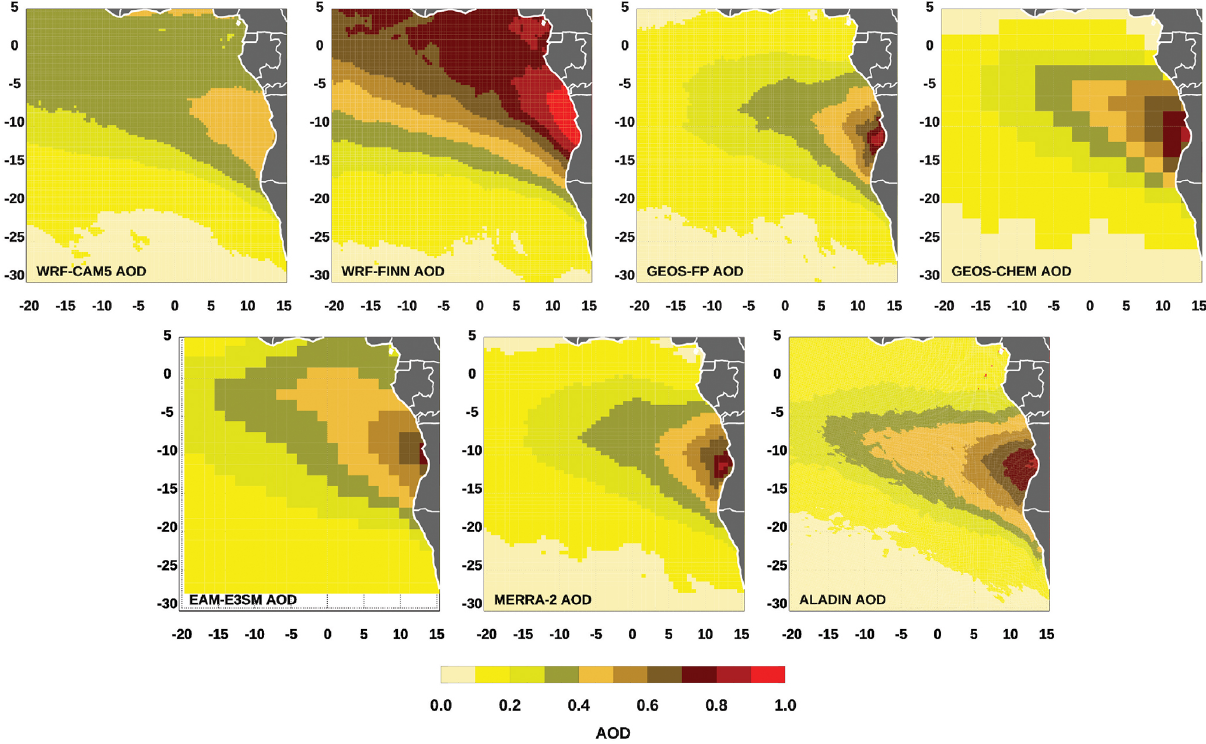
Figure 6. Monthly mean modeled total-column AOD at 12:00UTC for September